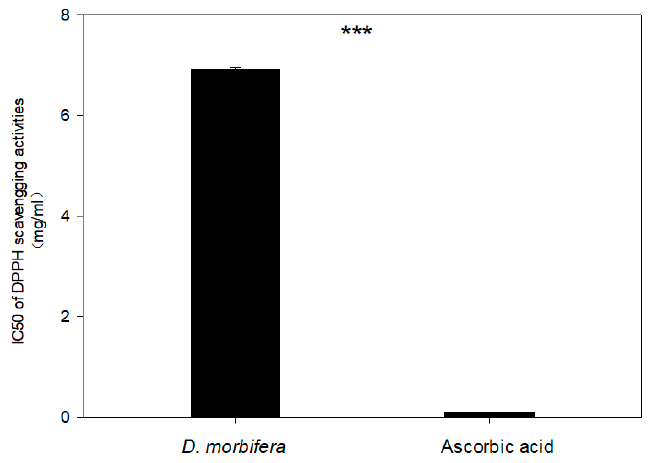
Figure 4. IC50 of DPPH scavenging activities of D. morbifera extract and ascorbic acid. The data are shown as the mean ± standard deviation and represent three replicate measurements. Significant difference set as *** p < 0.001.